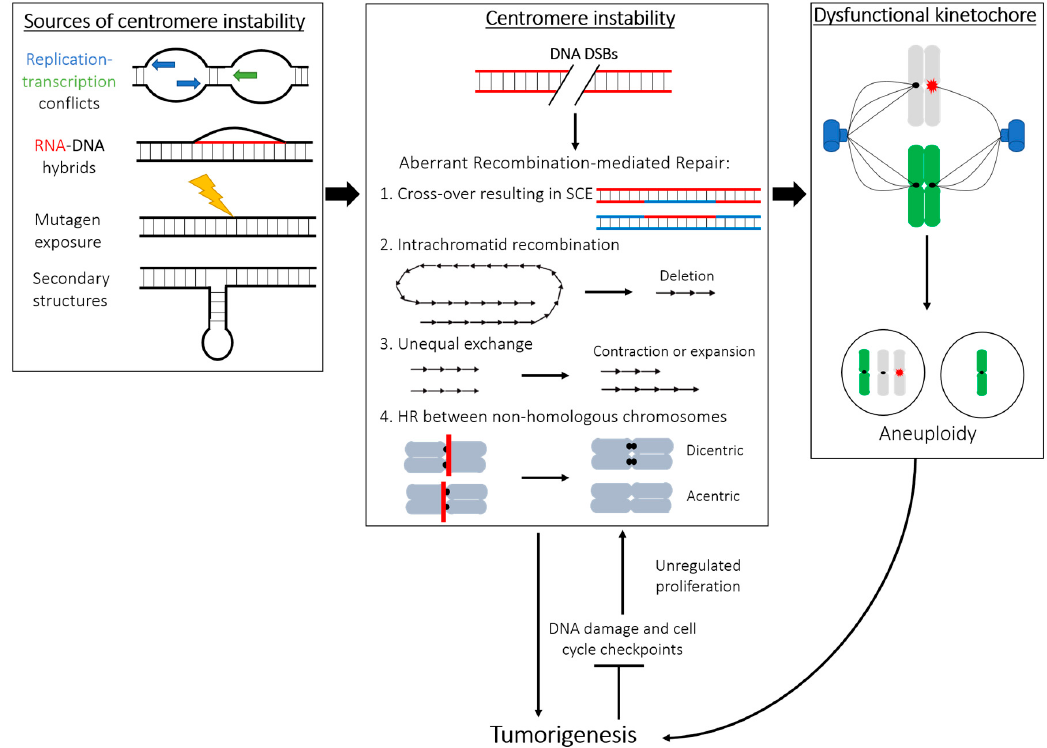
Figure 1. Centromere DNA instability as a contributor to aneuploidy and carcinogenesis. Left panel. Sources of centromere instability, such as replication–transcription conflicts, RNA–DNA hybrids forming R-loops, mutagen exposure and stochastic damage, as well as various secondary structures may underlie the inherent fragility of centromeres and propensity for DNA damage. Middle panel. These burdens may result in DNA double-stranded breaks (DSBs) formed at the centromere. Repair of these DSBs through recombination-dependent pathways, such as homologous recombination (HR), may disrupt centromere integrity in several ways: (1) Crossover between sister chromatids will lead to sister chromatid exchange (SCE), which has been reported at human centromeres. (2) Search for the homologous sequence may erroneously identify an identical or nearly identical sequence within the same chromatid downstream or upstream of the break site. Recombination between these two regions would result in DNA excision into an extrachromosomal circle and subsequent loss of alpha-satellite sequences. (3) Recombination may lead to unequal exchange, thereby introducing instability in the total size of the centromeric array. (4) HR at identical centromere sequences between different chromosomes can lead to the formation of dicentric and acentric chromosomes. Right panel. Rearrangements, changes, and especially loss, of alpha-satellite DNA may impact the centromere and, in turn, affect the formation of a functional kinetochore during mitosis. Centromere/kinetochore dysfunction increases the risk of chromosome missegregation and formation of aneuploid daughter cells. Aneuploidy can, in turn, promote tumorigenesis. Other routes may exist by which centromere instability promotes malignant transformation independent of kinetochore establishment, including altered transcription, delayed decatenation, structural integrity, etc. (see text in Section 4). Canonical DNA damage and cell division checkpoints become activated at specific stages during this process to prevent transformation. Inhibition of these failsafe pathways that restrict unregulated proliferative growth and continued cycling with subsequent increase in centromere/genome instability causes a short circuit with deleterious consequences that further promote mutagenesis and cancer